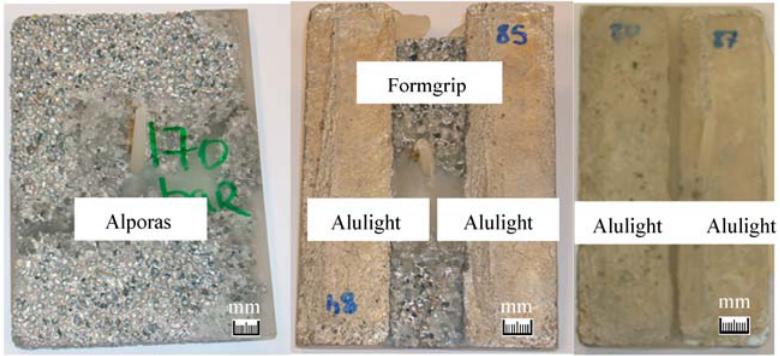
Figure 10. Different configurations for plastic injection over the aluminium foams.